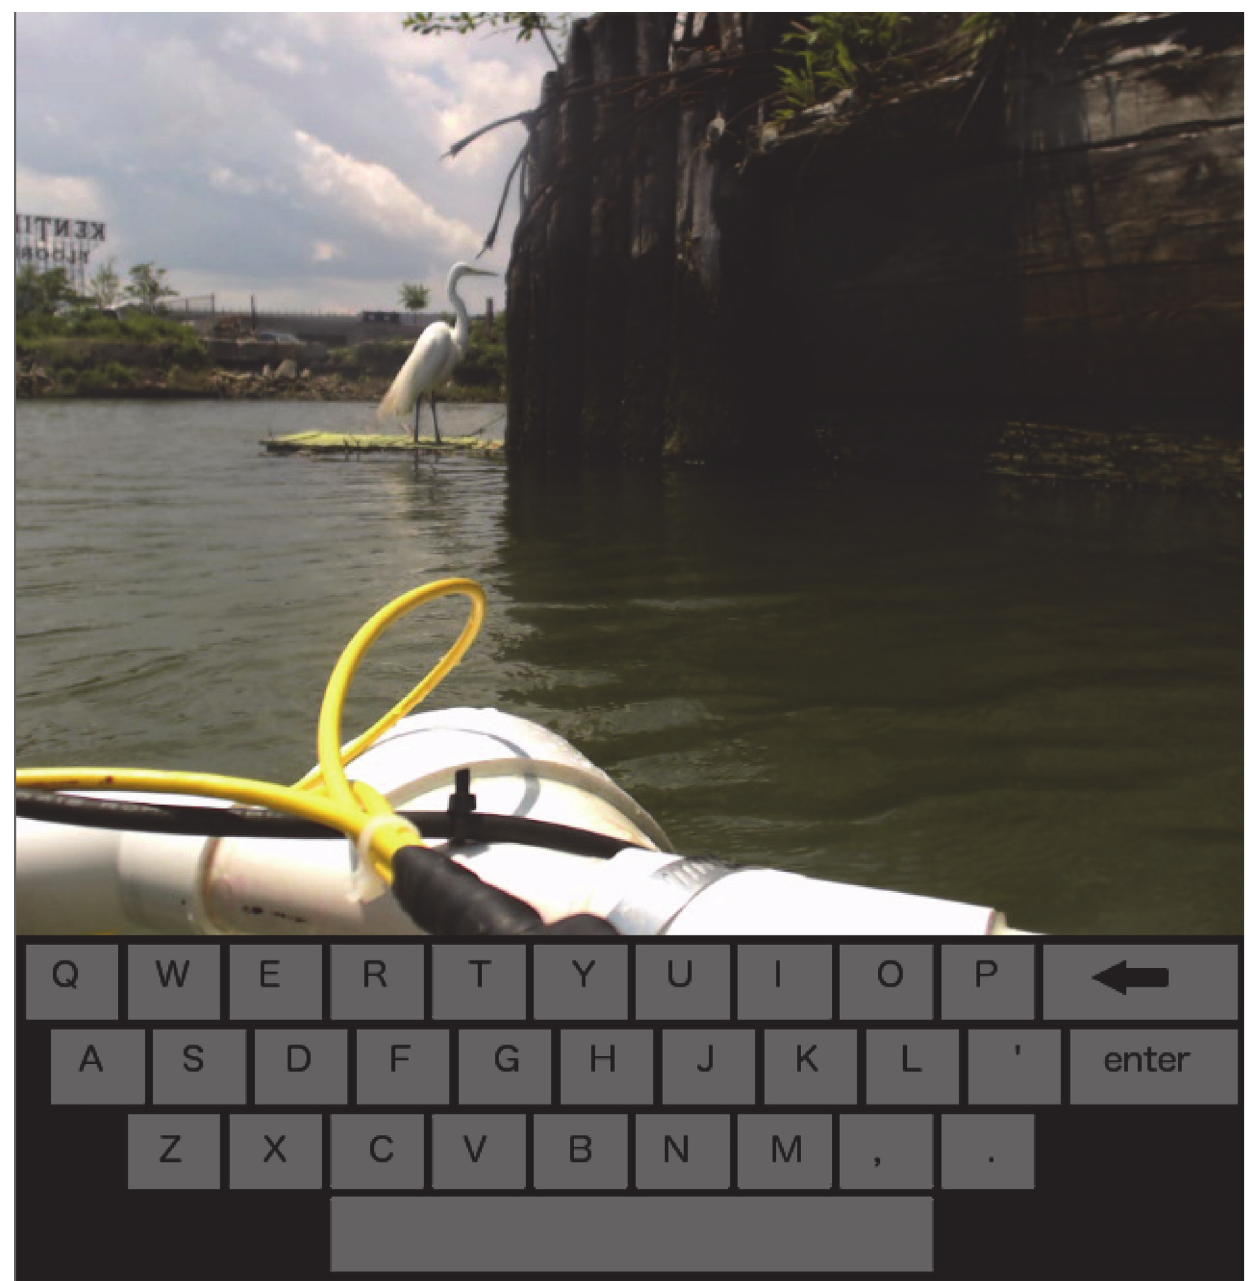
Fig 3. Example of image displayed during tagging mode with on-screen